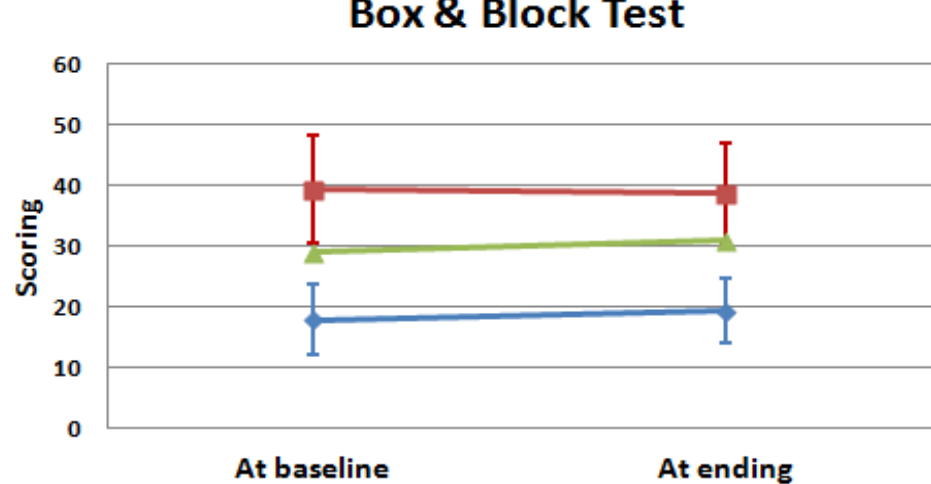
Figure 6. Graphical results in relation to baseline and end conditions for the Box and Block test. The tetraplegic group is expressed in blue, the paraplegic group in red and the case of a single patient in green.